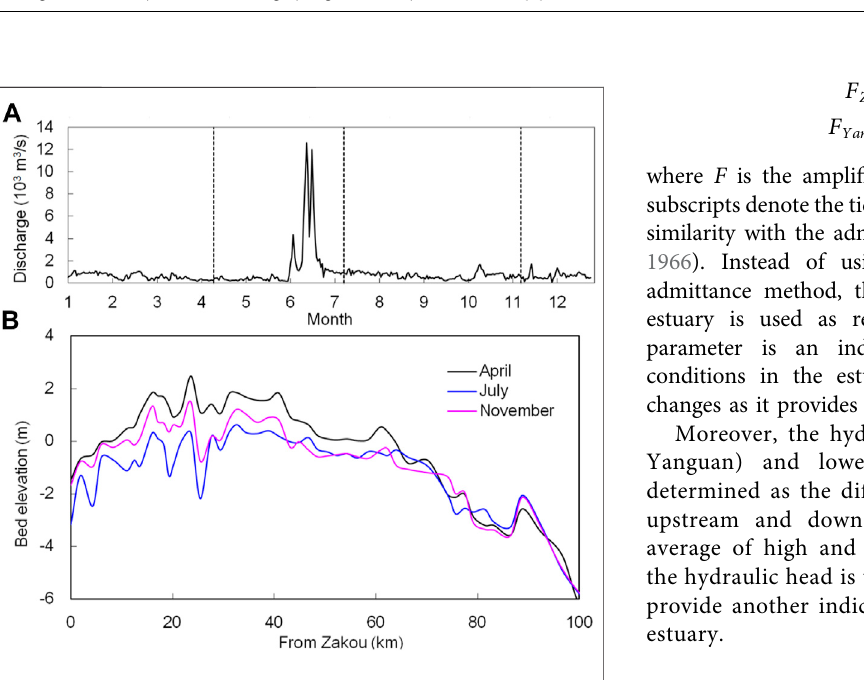
Frontiers in Earth Science |